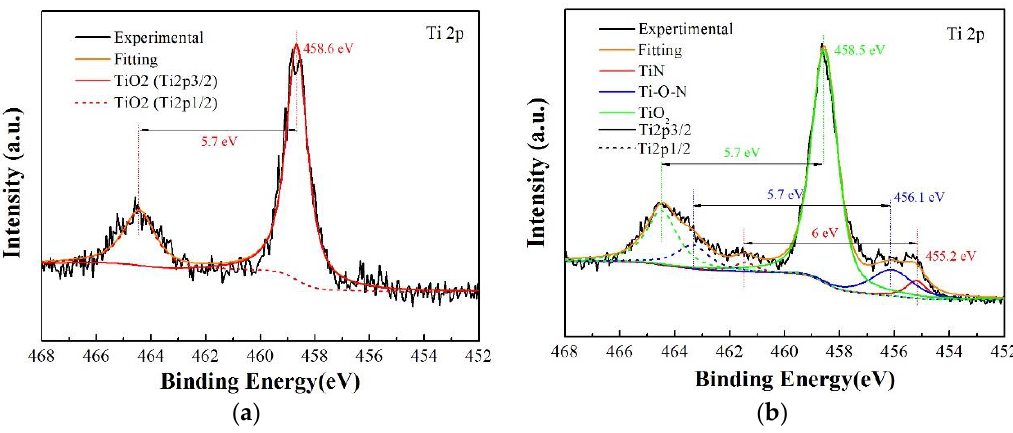
Figure 7. Photoelectron spectroscopy (XPS) Ti2p spectra of the Ti/TiN multilayer film at different normal loads; ( a ) 20 N, ( b ) 100 N.